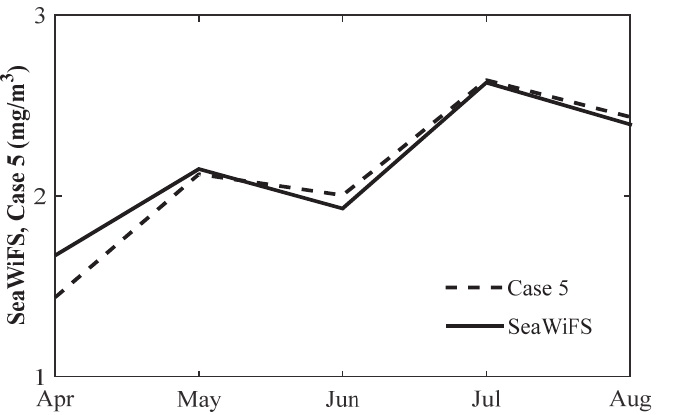
Figure 7. The seasonal cycle of 1998–2010 averaged chlorophyll concentration from SeaWiFS and model result (Case 5) over 29° N–32° N, 122.5° E–124° E.